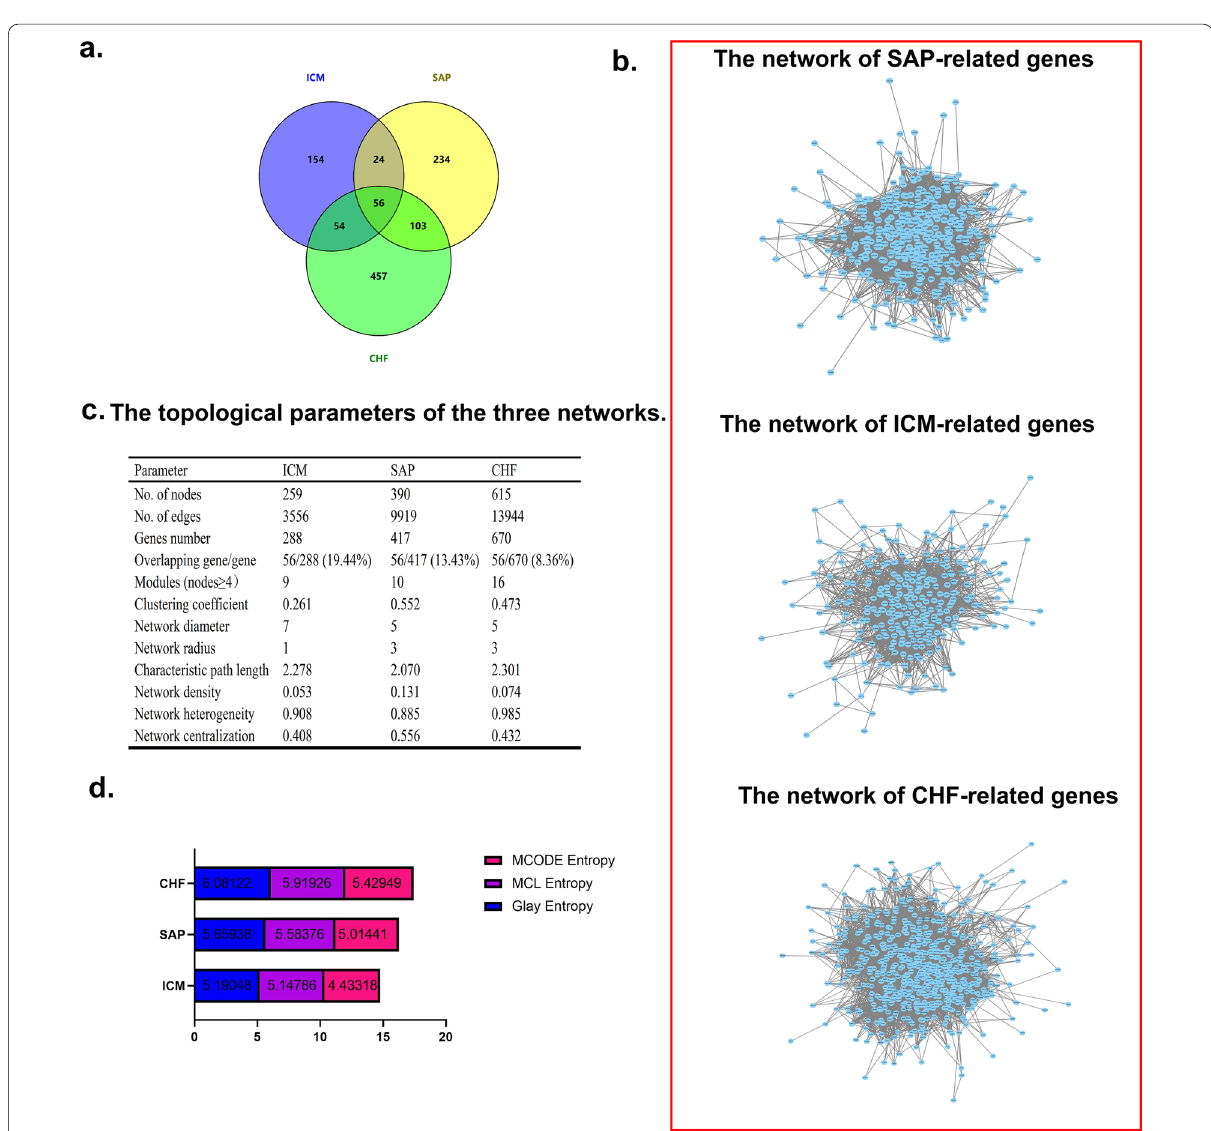
Fig. 1 Comparison of disease‑related genes and network analysis in SAP, ICM, and CHF. a Comparison of disease‑related genes in SAP, ICM, and CHF. b The network of SAP‑, ICM‑ and CHF‑related genes. c Topological parameters of the three networks. d The entropy calculation of the network in SAP, ICM, and